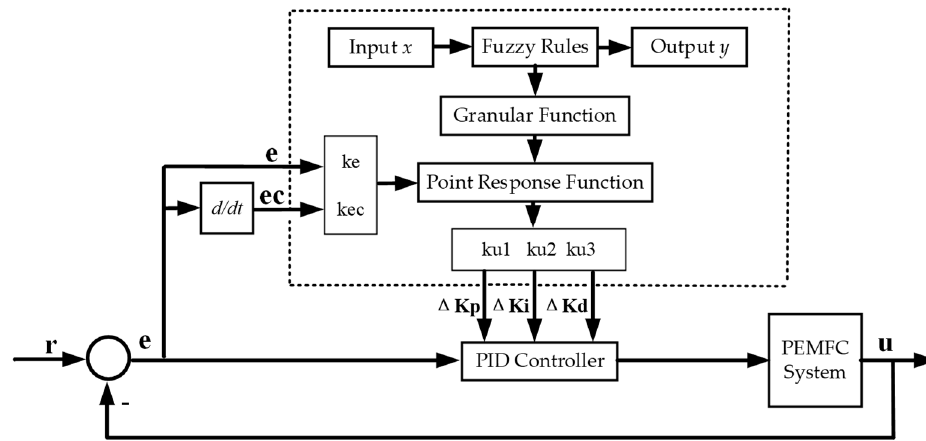
Energies 2021 , 14 , x FOR PEER REVIEW